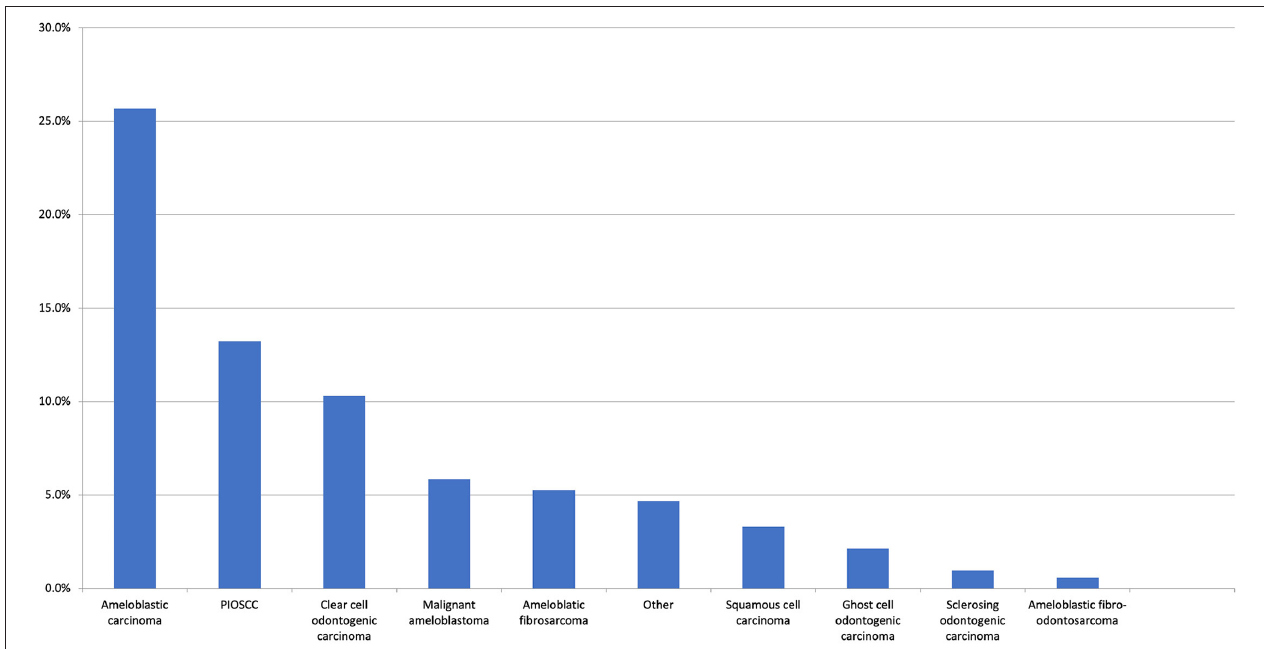
FIGURE 3 | The top 10 most common malignant first histological diagnoses. The “Other” category includes clear cell carcinoma (0.6%), adenocarcinoma NOS, metastatic carcinoma, and undifferentiated (all 0.4%). There were 13 other malignant entities reported at the same frequency (all 0.2%).